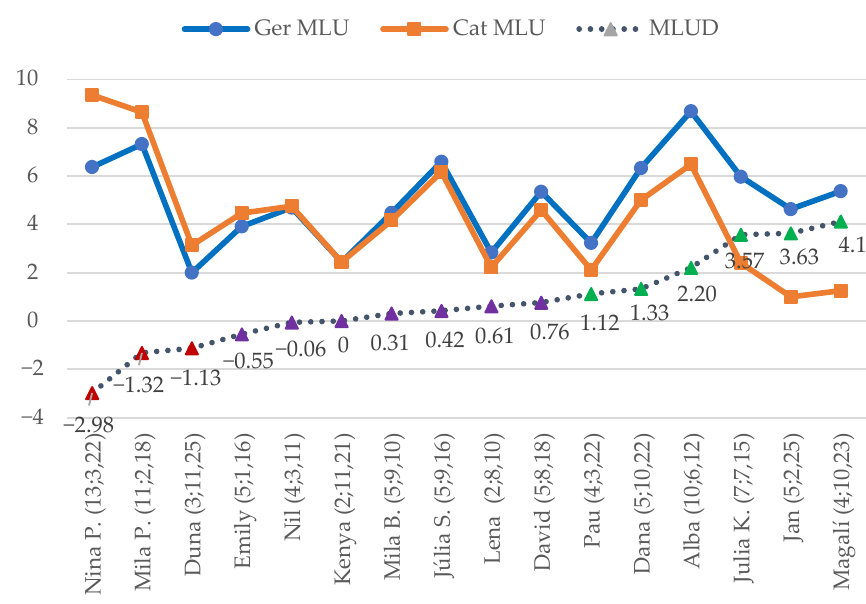
Figure 5. Children’s MLU in the MaL German and the HL Catalan and MLUD.